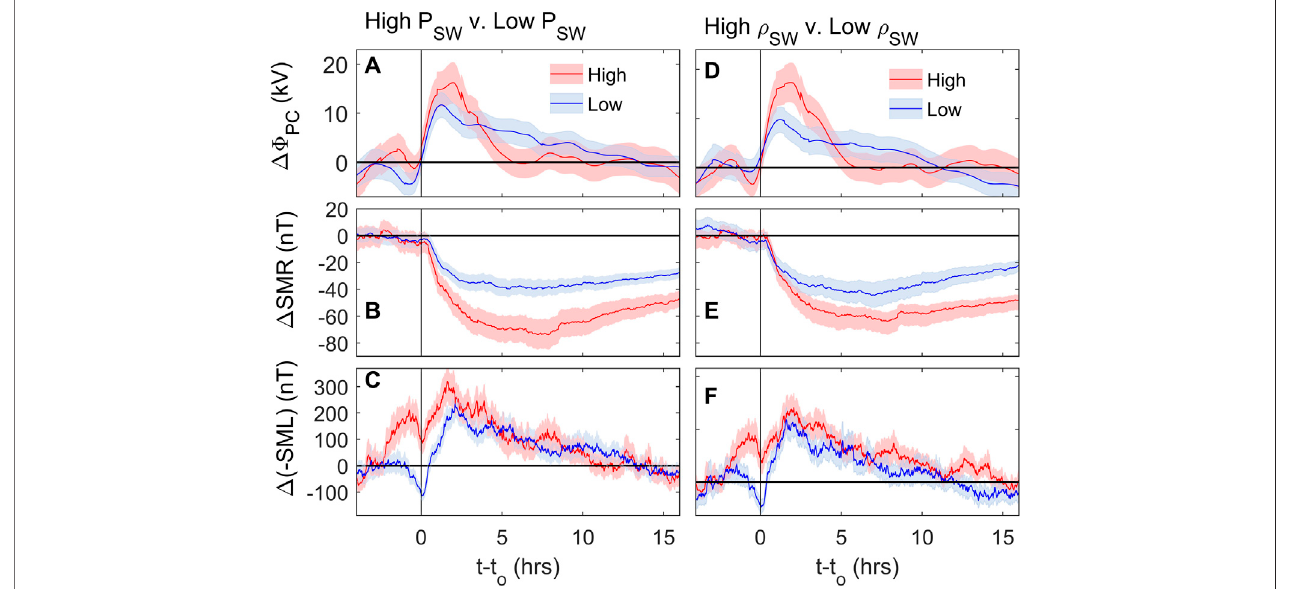
FIGURE 10 | Comparison of the terrestrial responses to the southward turning events of the IMF for (left column, parts A , B and C ) high- and low-solar wind dynamic pressure P SW and (right column, parts D , E and F ) high- and low-solar wind mass density ρ SW . In both cases red lines with pink uncertainty bands are for the “ high ” event subset and blue lines with pale blue uncertainty bands are for the “ low ” cases. Rows from top to bottom are for ( A and D ) transpolar voltage Φ the SMR index, ( C and F ) the SML index. Note that these plots are similar to those in (left column) Figure 9 and (right column) Figure 12 and are plotted here with high and low cases on a single panel to allow comparison. However, they are not quite the same as, to allow comparison, the pre-event means have here been subtracted from thevaluesat general elapsed time ( t - t o ) to show the response and sothe plots show the changes in Φ PC , SMR and SML , denoted by ΔΦ PC , Δ SMR and Δ SML ,